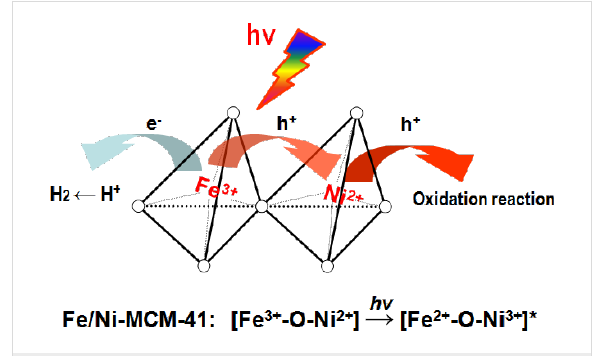
Figure 3: Proposed mechanism for charge transfer in Fe/Ni co-doped MCM-41. Reprinted with permission from [21]. Copyright (2014)